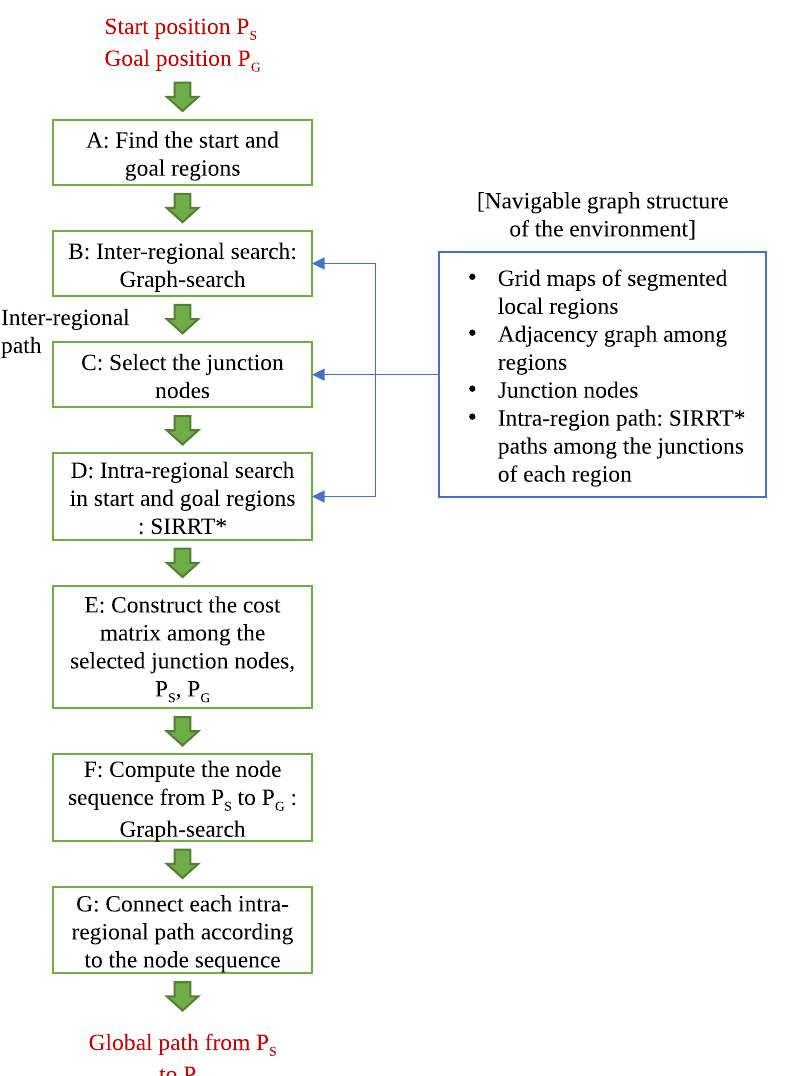
Figure 5. The steps of hierarchical